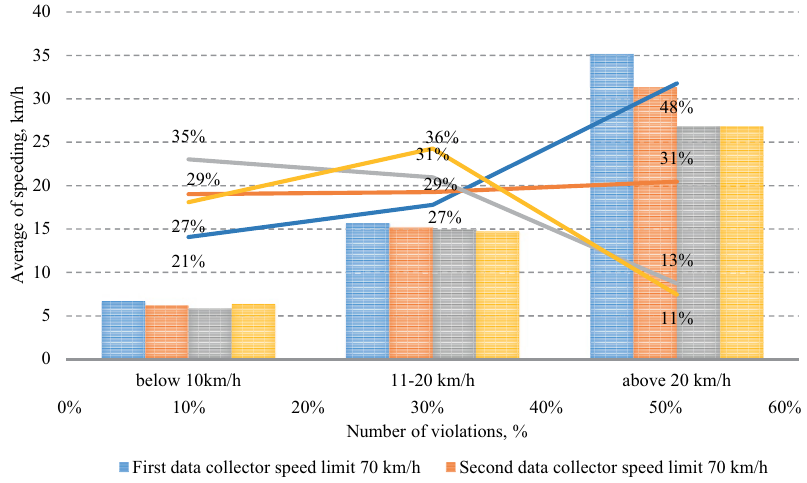
Figure 4. Speed distribution in a roadwork